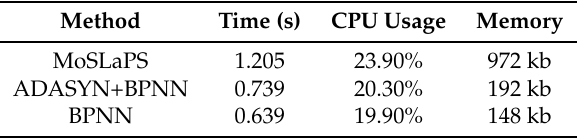
Table 7. Comparisons of time consumption and resource usage.